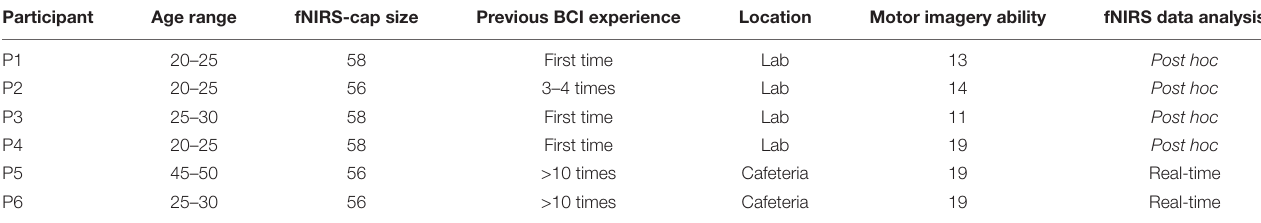
TABLE 1 | Participant characteristics.